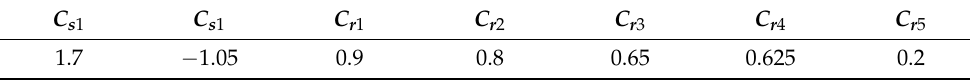
Table 3. Constants of pressure strain correlation term Φ ij in SSG RSM.